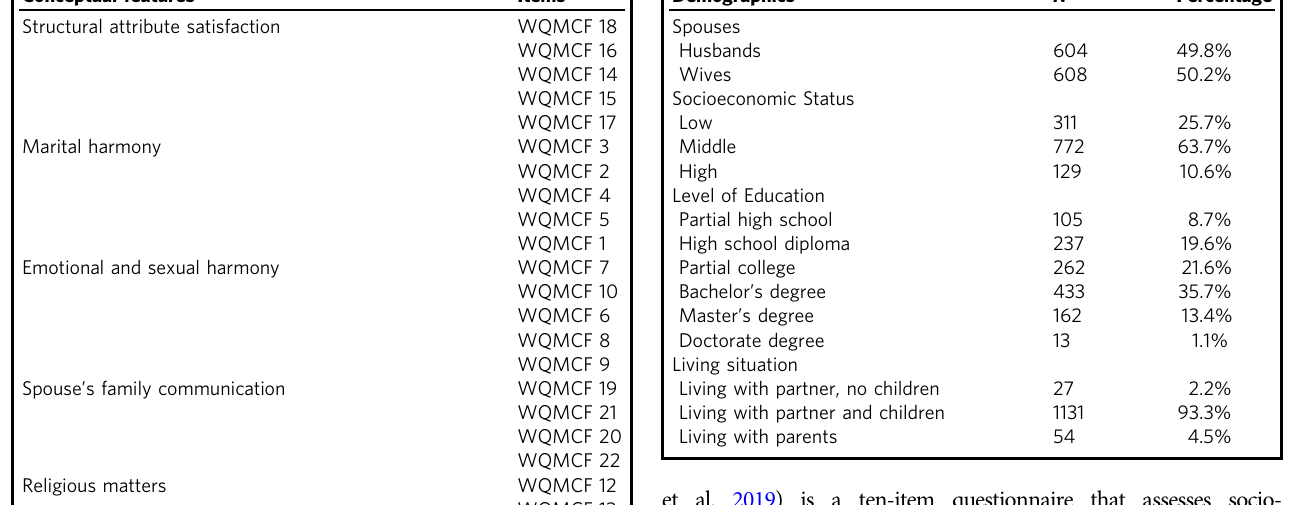
Table 1 Conceptual characteristics and corresponding items. Conceptual features Items Structural attribute satisfaction